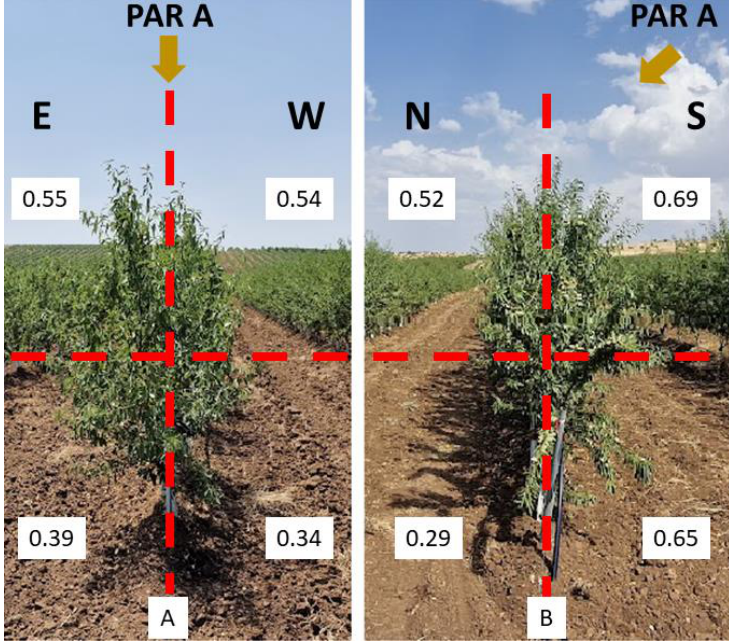
Figure 6. Available PAR (% of incident PAR) at DOY 229 for year 2022, in different expositions (E, W, S, N) into two different layers: low (L; 0.5 – 1.4 m) and top (T; 1.4 – 2.3 m). ( A ): hedgerows N – S S, N) into two different layers: low (L; 0.5–1.4 m) and top (T; 1.4–2.3 m). ( A ): hedgerows N–S oriented; ( B ): hedgerows E – W oriented.